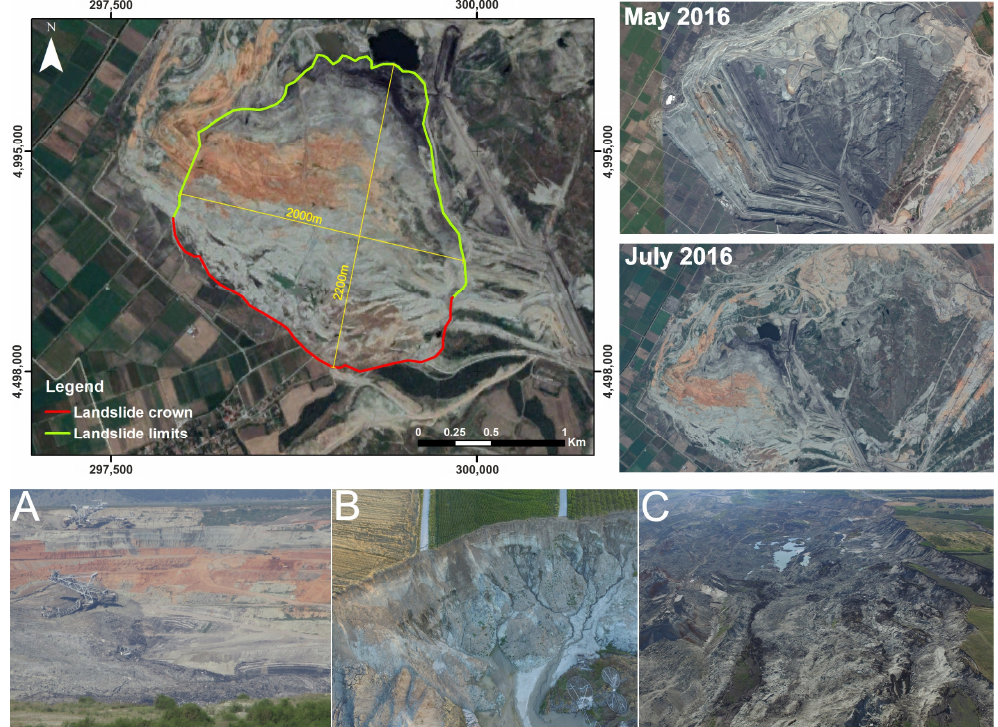
Figure 5. The spatial extent of the 10 June 2017 landslide at the Amyntaio mine, as shown by satellite imagery. Images obtained by Google Earth. ( A – C ) show oblique views of the landslide area. ( A ) one of the bucket wheel excavators buried inside the sliding mass; ( B ) panoramic view of the landslide scarp in front of the Anargyroi village; and ( C ) panoramic view of the landslide head looking towards East West.